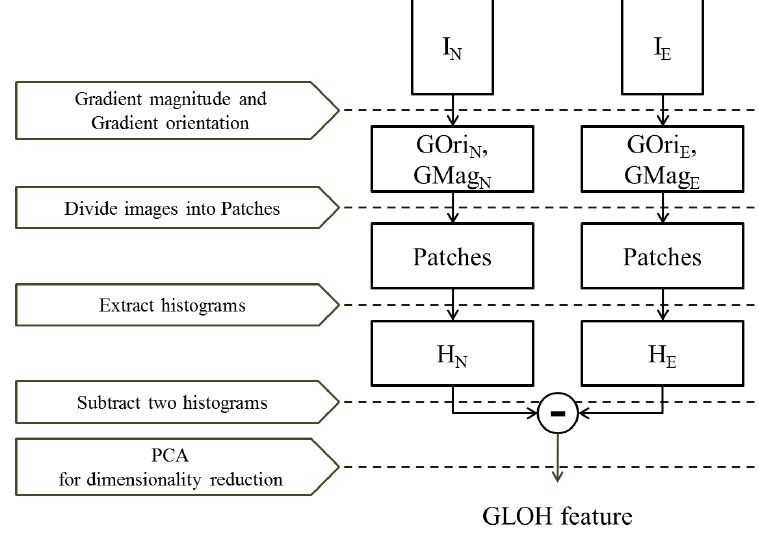
Figure 14. Flowchart of gradient location and orientation histogram (GLOH) feature